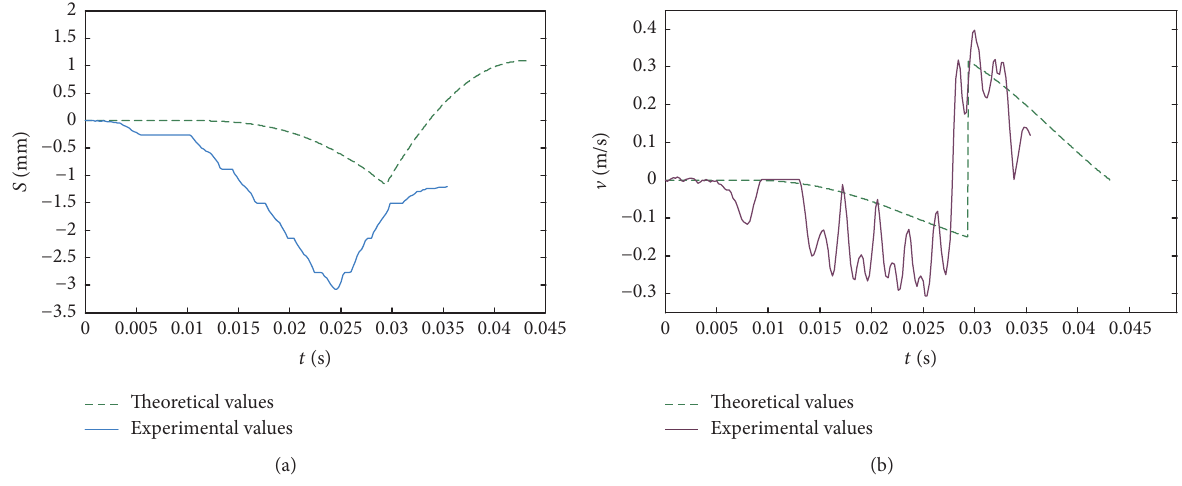
Figure 7: Comparison analysis between the theoretical and experiment base on A point. (a) The displacement curve with time. (b) The velocity curve with time. The collision conditions: 𝑀 0 = 801 g, 𝑀 1 = 355 g, 𝑀 2 = 846 g, 𝑘 0 = 4.9 N/mm, and 𝑘 1 = 1 N/mm.